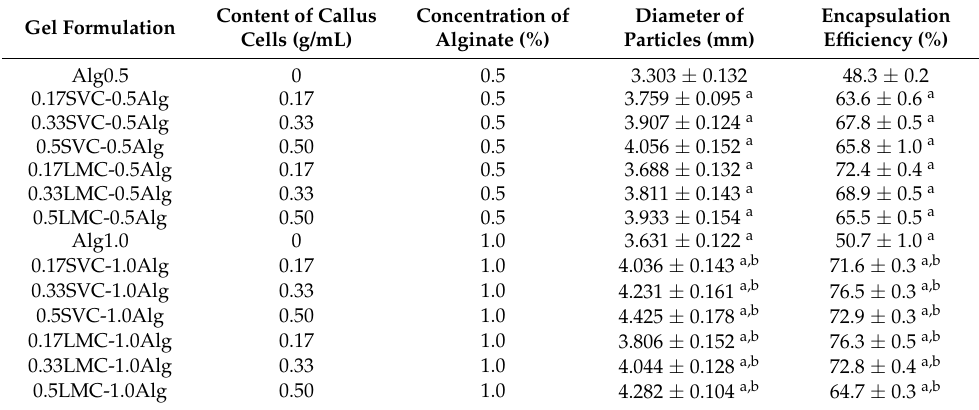
Table 1. Characterization of hydrogel particles.